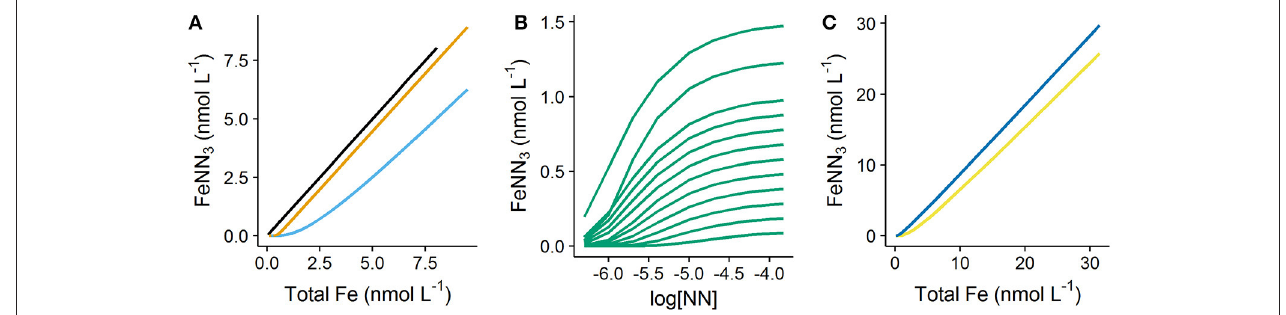
FIGURE 1 | Titrations simulated in visual MINTEQ using 1-nitroso-2-naphthol (NN) as the added ligand. Eleven simulations were undertaken with increasing starting DFe concentrations (0.05–1.5 nmol L − 1 ). (A) Single window forward titrations (iron additions to 8 nmol L − 1 ) of seawater with no organic matter (black line), seawater with 0.5nmol L − 1 diethylenetriaminepentaacetic acid (orange line) and seawater with 64 µ mol L − 1 dissolved organic carbon as fulvic acid (sky blue line). The graph illustrates titrations simulated with the lowest detection window applied in this study ( α FeNN 3( Fe ′ ) = 146). (B) Reverse titrations (NN concentrations increased) of seawater with 64 µ mol L − 1 dissolved organic carbon as fulvic acid and (C) “Multiwindow” forward titrations of seawater with 64 µ mol L − 1 dissolved organic carbon as fulvic acid. Two different detection windows were used, α FeNN 3( Fe ′ ) = 146 (yellow line) and α FeNN 3( Fe ′ ) = 2,348 (dark blue line). The applied initial dissolved iron concentrations are clearly visible in (B) , but not visible in (A,C) as the individual titration curves overly each other.